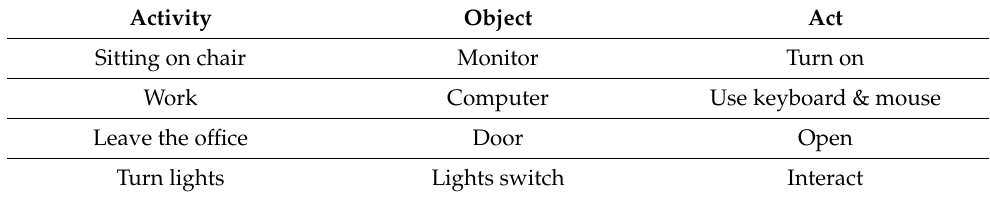
Table 2. Distinct energy-related behaviors.